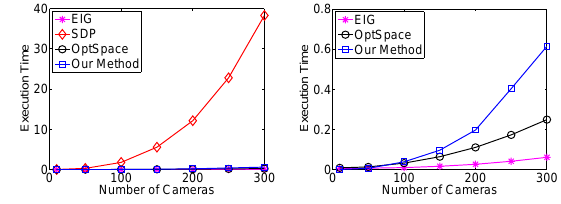
Figure 2: Execution times (in seconds) of exterior attitude esti- mation as a function of the number of cameras. The right figure is a zoom of the left